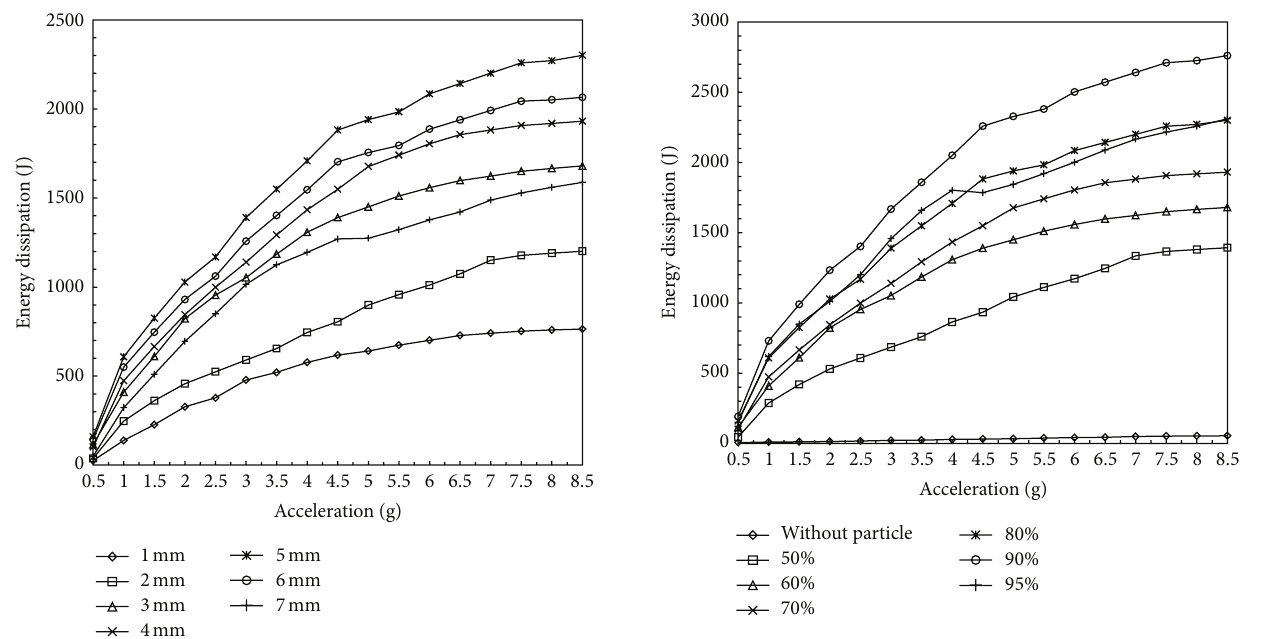
Figure 12: The experimental results for the different particle size.